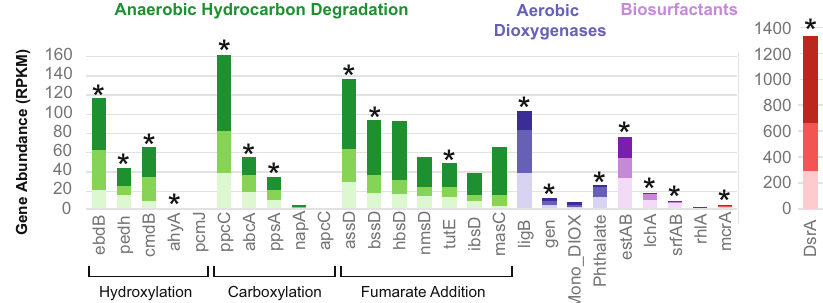
Fig. 5 Comparison of gene abundances across coal seams. Gene abundance was calculated using the coverage of each gene per kilobase of transcript per million mapped reads (RPKM) for each gene of interest from all shotgun metagenomic samples. Representative genes for each of the databases tested are presented here, with genes of interest containing the highest gene abundance in one of the samples and/or being present in the BONCAT + sample. The coverage of each gene was calculated using the average depth of coverage across the contig the gene was identi fi ed. All non-duplicate contigs from the entire community containing the gene of interest above 40% identity were summed and reported here. The different genes are grouped based on anaerobic hydrocarbon degradation strategies (green), aerobic dioxygenases (blue), biosurfactant (purple), and sulfate reduction/ methanogenesis genes (red). All three environmental samples are represented in a color gradient with the high-sulfate coal seam, N-H in the darkest shade (top), and two low-sulfate coal seams, T-L (middle) with medium shade and FG-L (bottom) in the lightest shade. Stars indicate the presence of the individual gene in the BONCAT + sample. The DsrA gene has its own axis because it had a greater overall gene